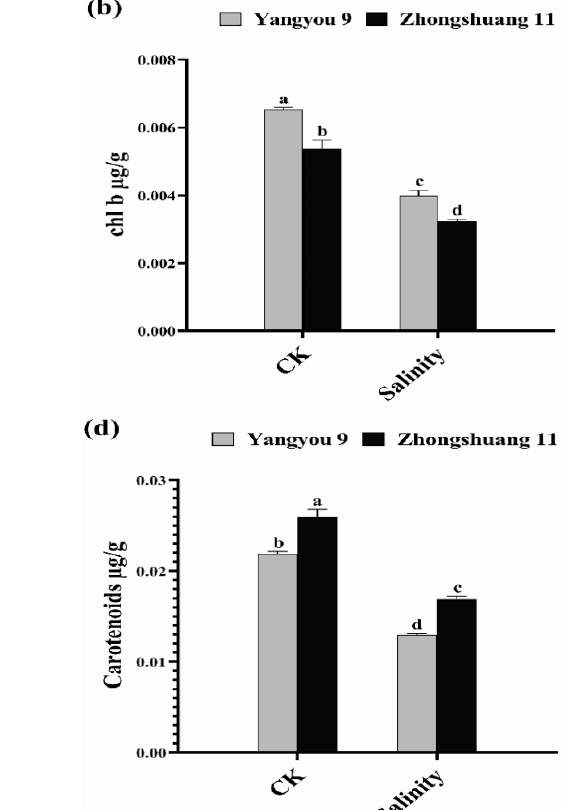
Figure 1. Impact of NaCl treatment on seedling growth of ( a ) Yangza 11, ( b ) Zhongshuang 11, ( c ) Huayouza 62, ( d ) Fengyou 520, and ( e ) Yangyou 9 rapeseed cultivars during the early seedling stage. Scale bar: 1 cm.